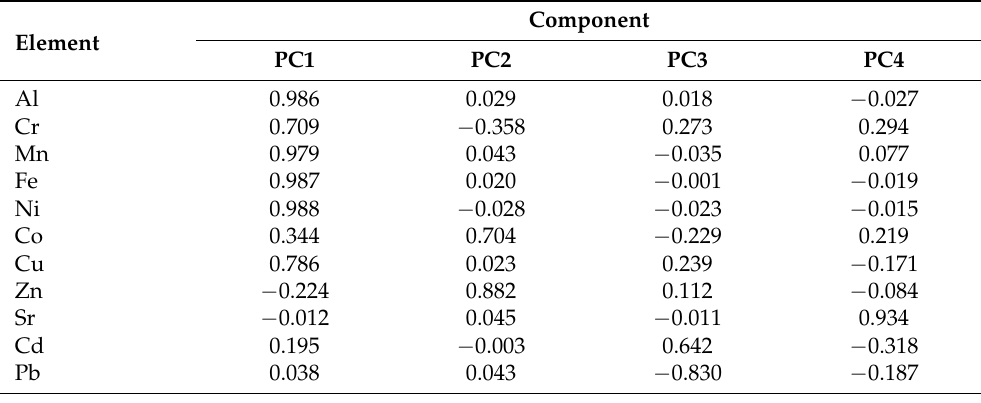
Table 12. Rotational component matrix (Varimax with Kaiser normalization) for experimental variables in the drinking water samples (N = 21).